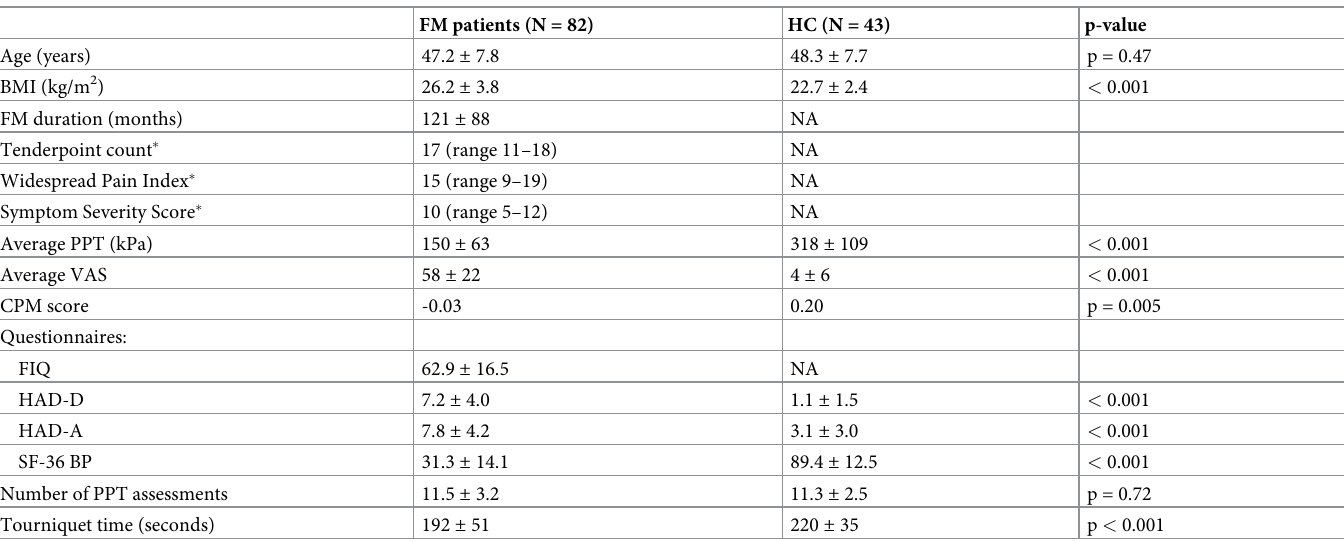
Table 1. Descriptives of study population.